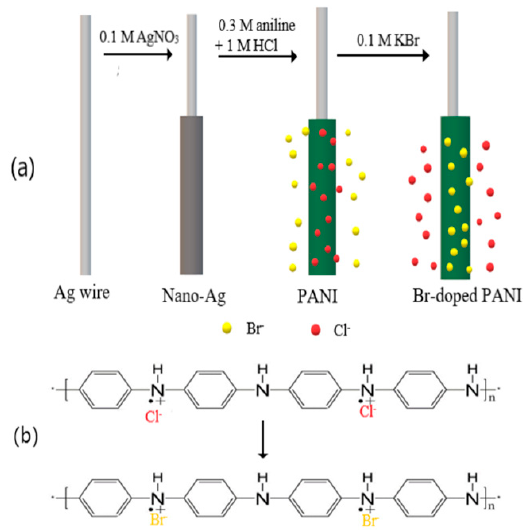
Figure1. Schematicdiagramofelectrodefabricationsteps( a )andmolecularstructureofchloride-doped( b Figure 1. Schematic diagram of electrode fabrication steps ( a ) and molecular structure of chloride-doped ( b ).